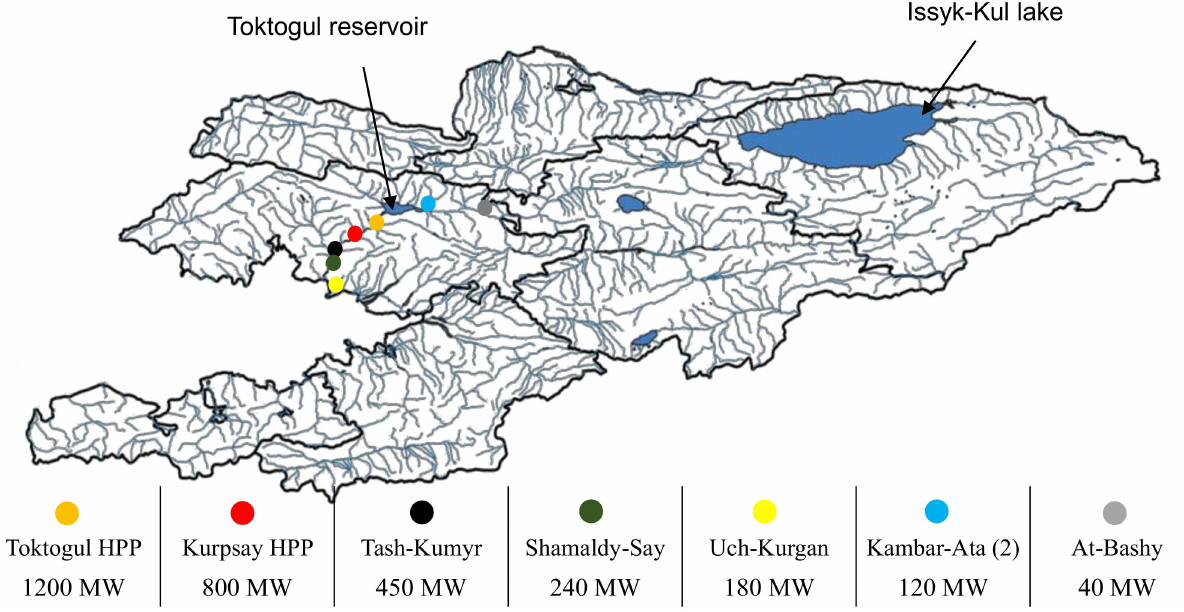
Figure 4. Water resources of Kyrgyzstan and key hydropower plants of Kyrgyzstan (own illustration based on